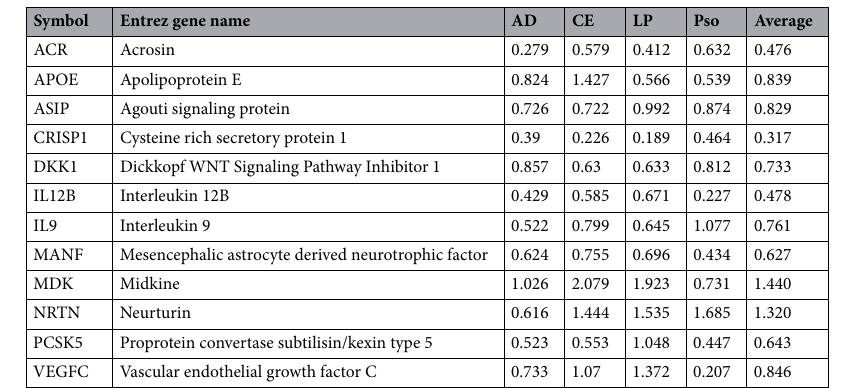
Table 2. Measurable common biomarkers in inflammatory skin